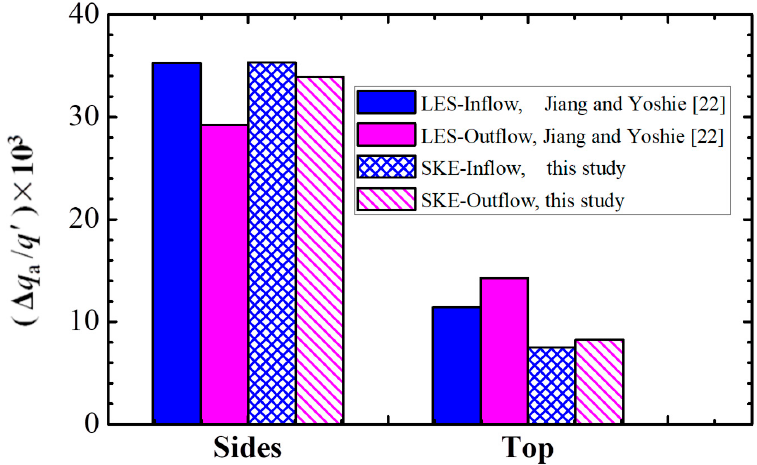
Figure 3. Comparison of air flow rates between standard k - ε model (SKE) and large-eddy simulation (LES).